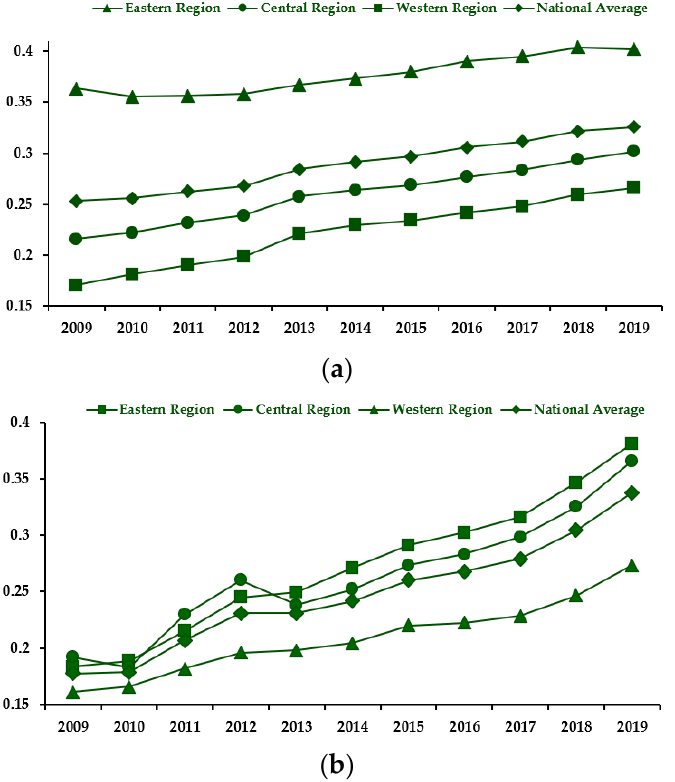
Figure 3. ( a ) National and regional levels of high-quality economic development. ( b ) National and regional levels of green financial development. regional levels of green financial development. Table 2. Green finance indicator